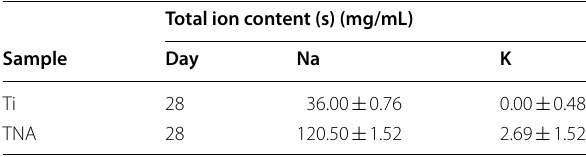
Release of Na and K was measured for the Ti alloy and also TNA nanosurface in SBF after 28 days of immersion